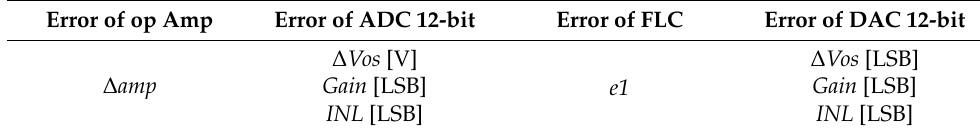
Table 2. AGC system errors.